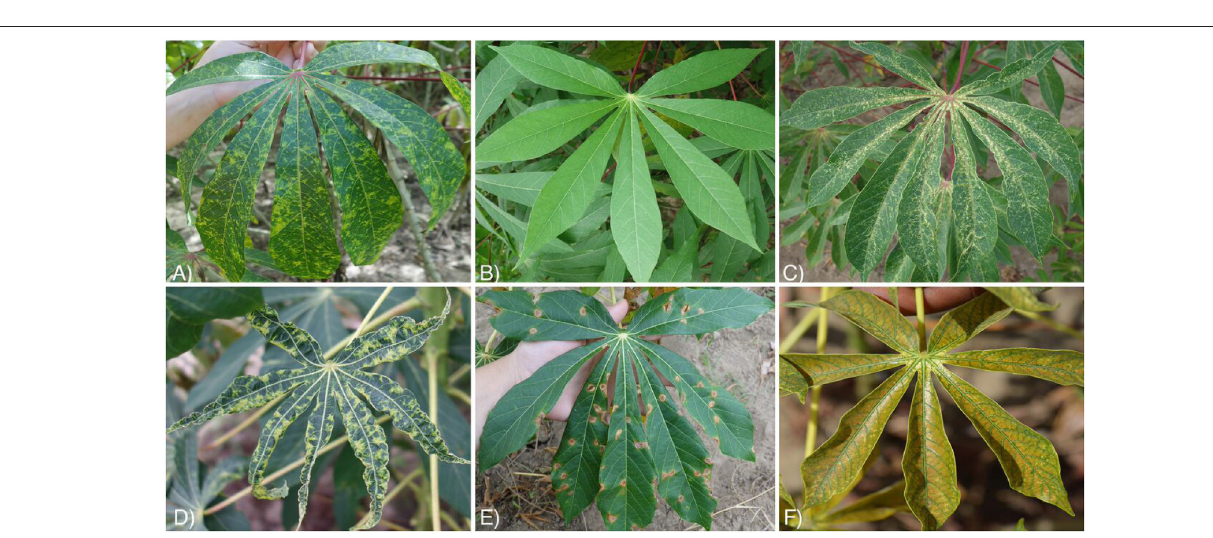
FIGURE 2 | Examples of images with in field backgrounds from 6 classes in the original cassava dataset. (A) Cassava brown streak disease (CBSD), (B) Healthy, (C) Green mite damage (GMD), (D) Cassava mosaic disease (CMD), (E) Brown leaf spot (BLS), (F) Red mite damage